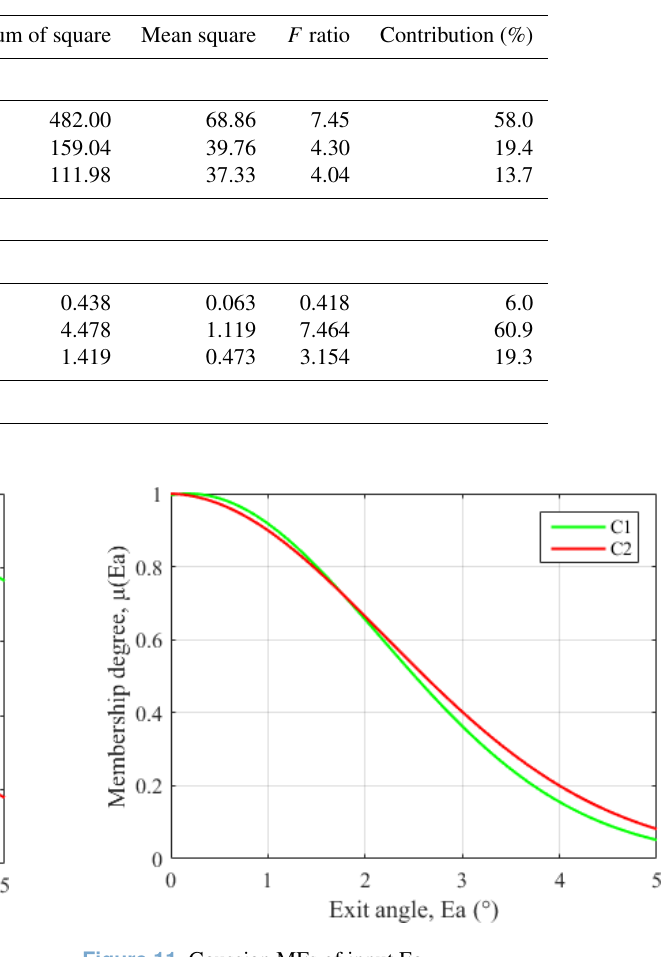
Figure 10. Gaussian MFs of input f z . Figure 11. Gaussian MFs of input